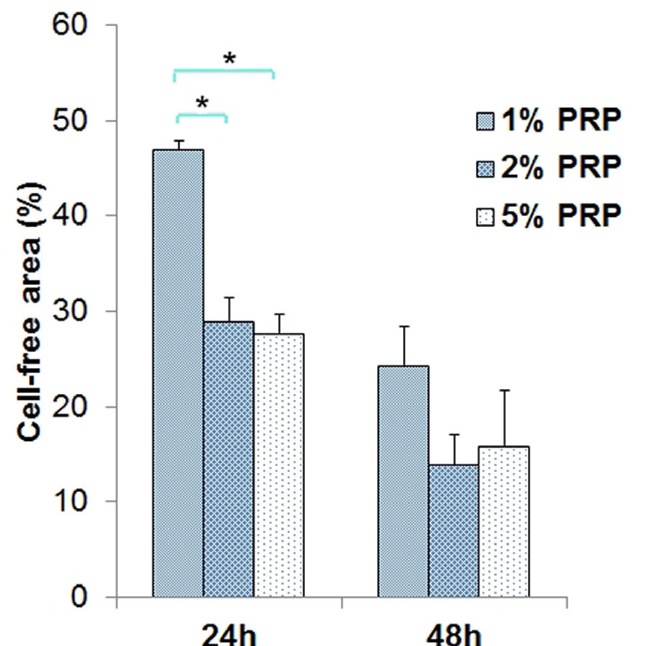
Figure 7- Cell-free area percentage in media with PRP at 24 hours and 48 hours (h) (*